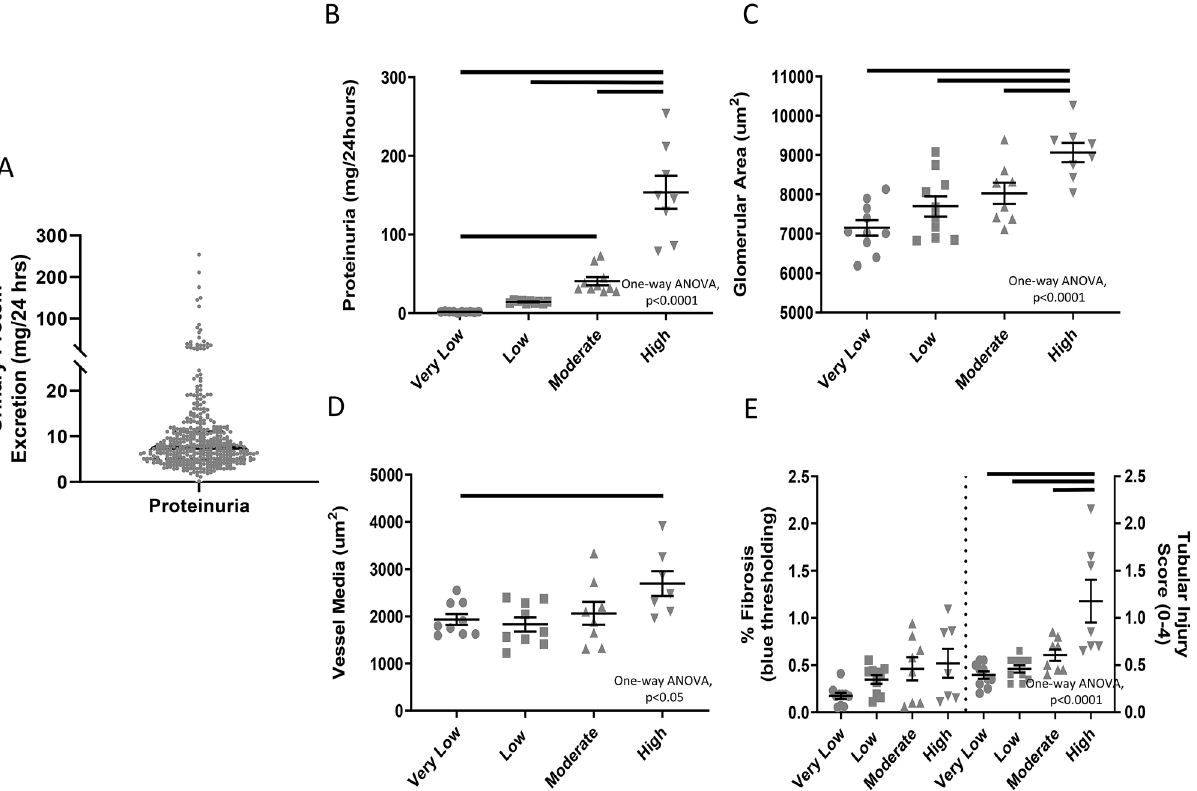
Figure 1. Distribution of urinary protein excretion (UPE) and the relationship between UPE and histological analysis of the kidney in HS rats. ( A ) 24-week old HS rats (n = 425) exhibit strong variation in UPE (mg/24 h). The thick black horizontal line indicates the median with the dashed lines denoting 25% and 75% quartiles, respectively. ( B ) UPE is shown for a sub-set of rats selected for histological analysis from one of four groups: very low, low, moderate, and high UPE. Histological analysis demonstrates that there is a statistically significant increase in ( C ) glomerular area and ( D ) vessel hypertrophy in rats with high proteinuria. ( E ) Although HS rats exhibit relatively limited fibrosis, those with high proteinuria exhibit significantly higher scores of tubular injury. Solid horizontal bars represent statistically significant differences based on a one-way ANOVA ( p < 0.0001), the black lines above the bar graph denote p < 0.05 between each